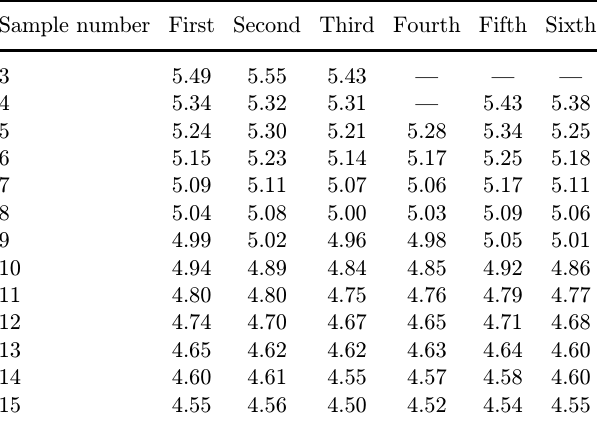
Table 1. The pH values of acid precipitation